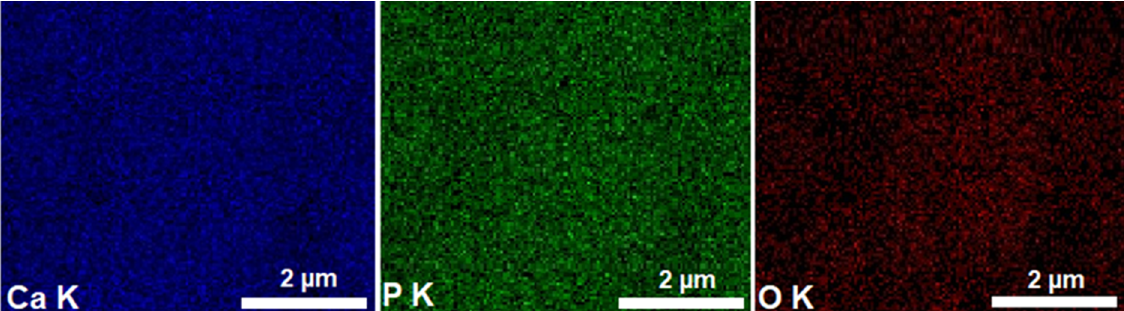
Figure 2. Elemental distribution maps obtained of HAp samples.